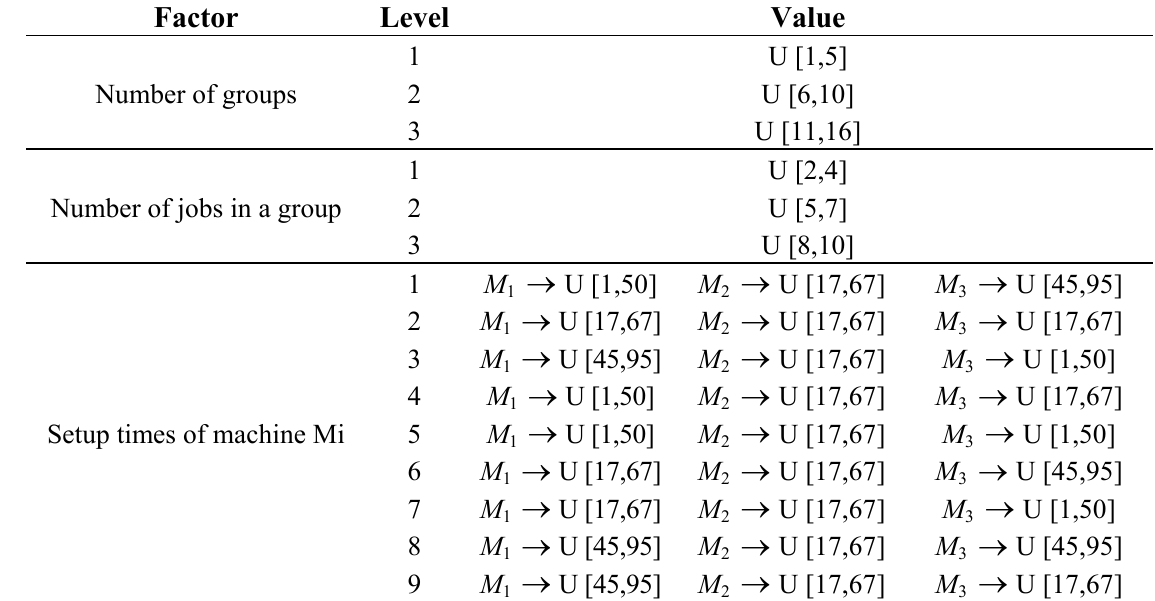
Table 4. Sub-benchmark of instances for the 3-machine FDSGS problem.